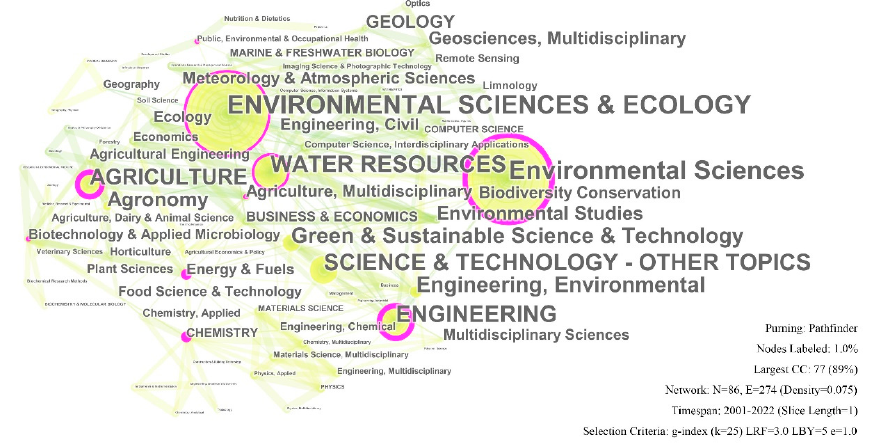
Figure 2. Co-occurrence network of categories.